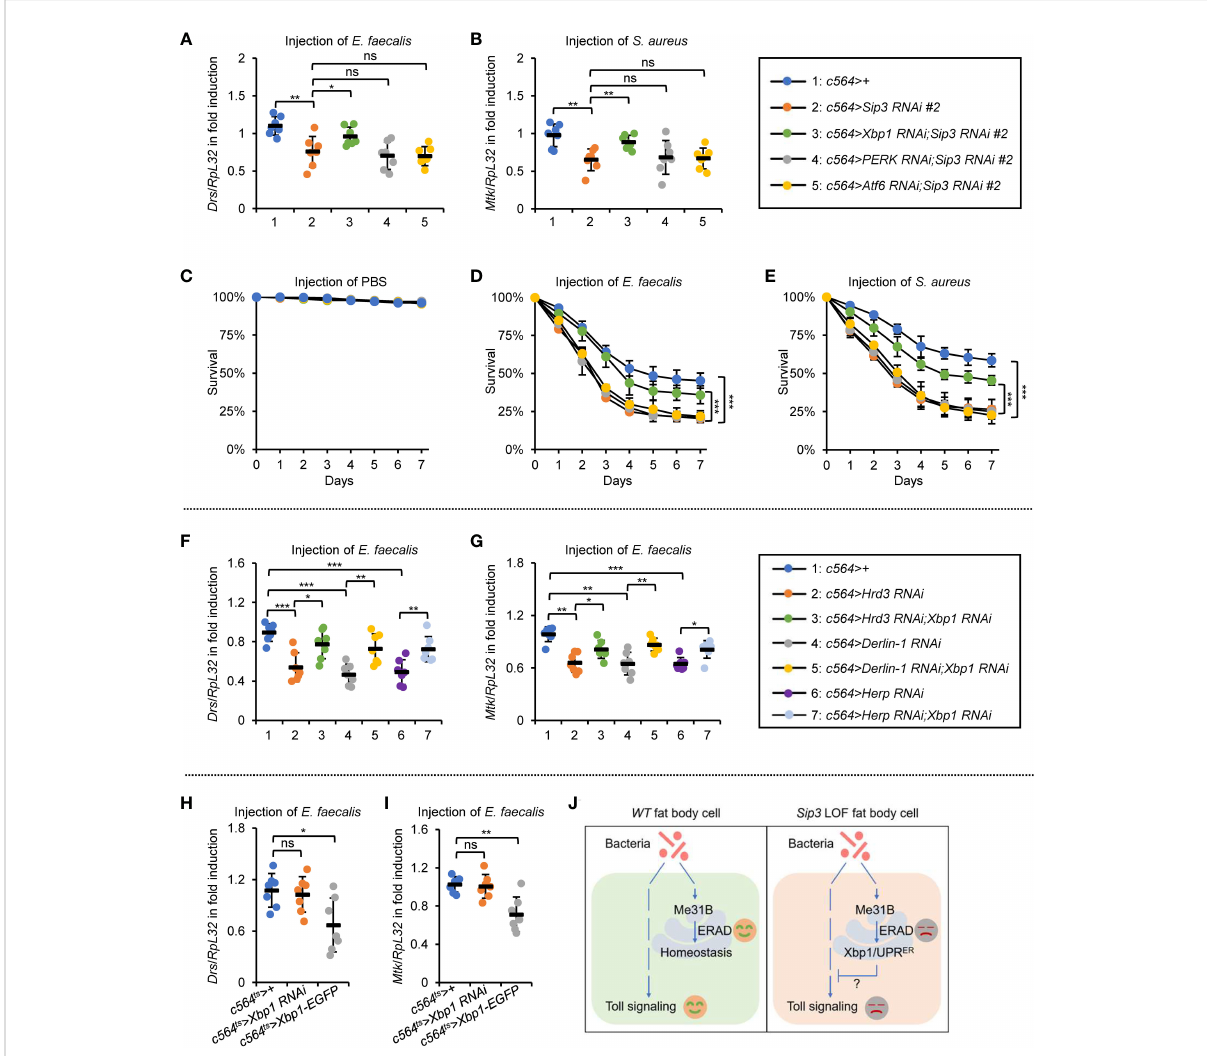
FIGURE 5 ERAD controls the Toll innate immunity partially via the Xbp1 axis of UPR ER . (A, B) Flies including 1: c564>+ , 2: c564>Sip3 RNAi #2 , 3: c564>Xbp1 RNAi;Sip3 RNAi #2 , 4: c564>PERK RNAi;Sip3 RNAi #2 , and 5: c564>Atf6 RNAi;Sip3 RNAi #2 were infected with E. faecalis , followed by RT-qPCR assays. Each dot represents one independent replicate (10 fl ies for each replicate). (C – E) Flies with same genotypes as in (A) were injected with sterile PBS (C) , E. faecalis (D) , or S. aureus (E) , followed by survival rate assays. The numbers of fl ies were as follows. In (C) , c564>+ : 106, 102,